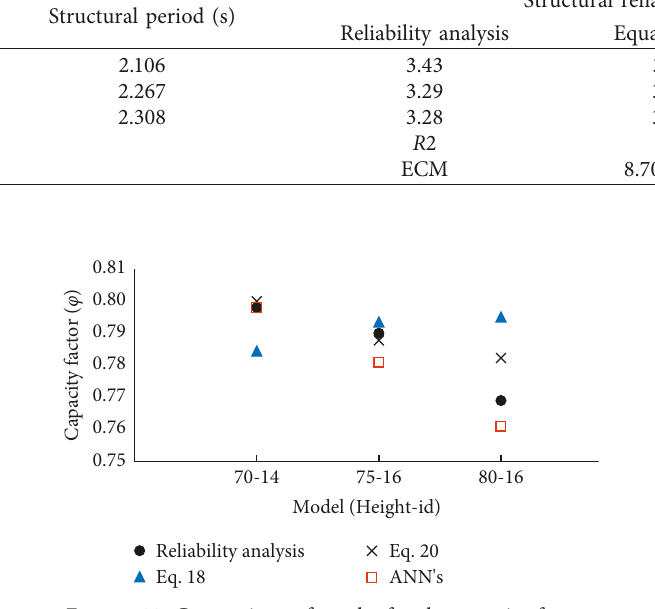
Figure 11: Comparison of results for the capacity